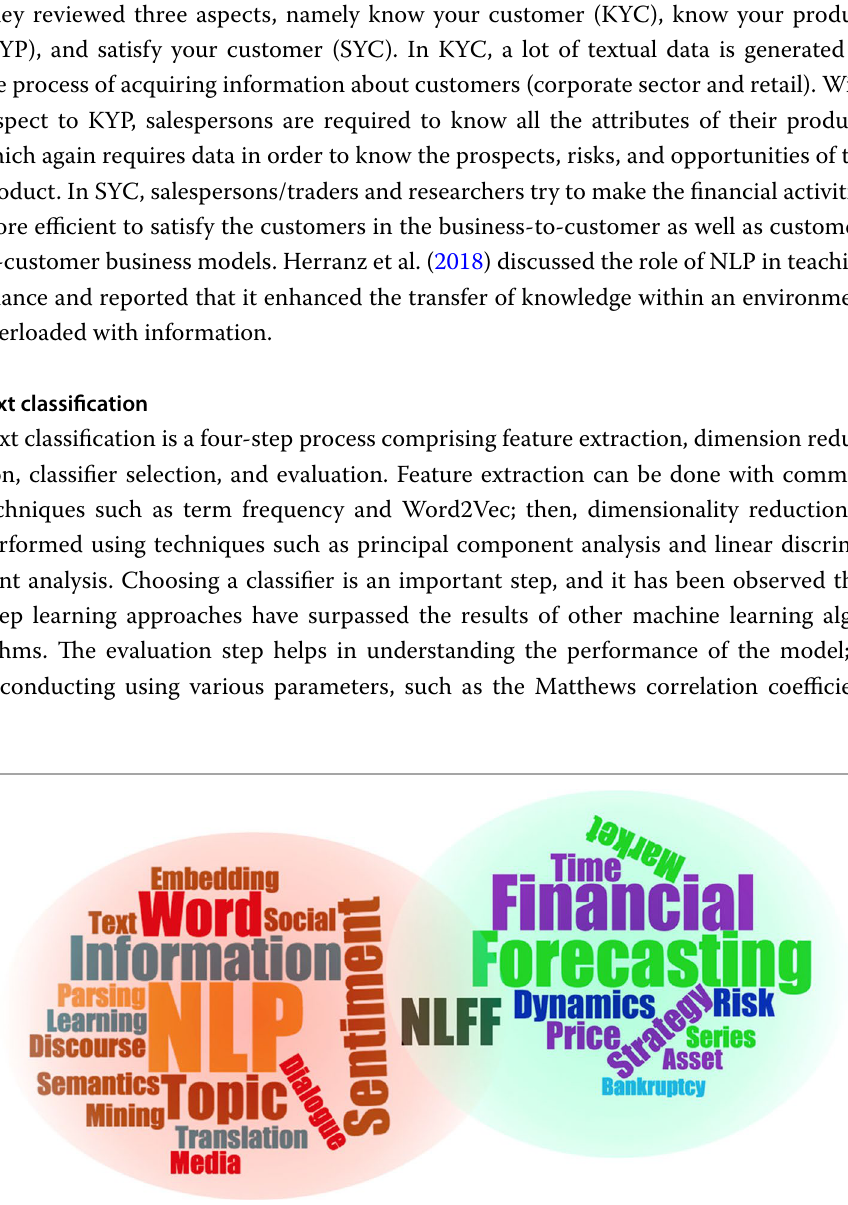
Fig. 1 An intersection of NLP and financial forecasting to illustrate the concept of NLFF (Xing et al.